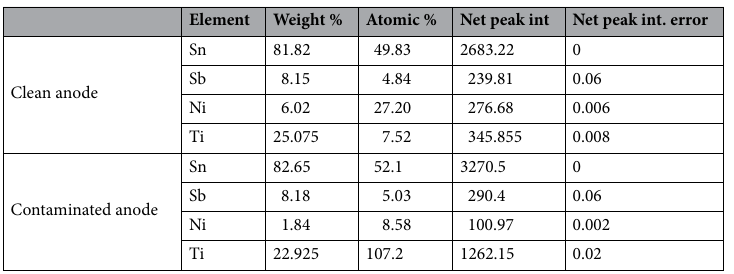
Element Weight % Atomic % Net peak int Net peak int.